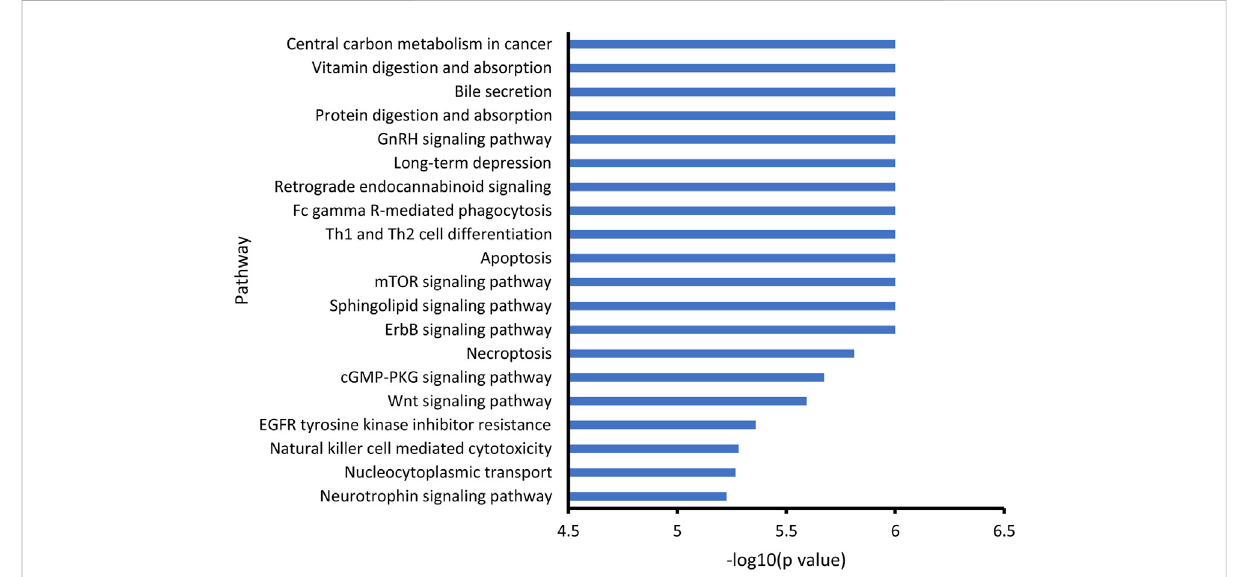
FIGURE 3 KEGG enrichment of noise-associated metabolites. R packages “ KEGGREST ” and “ FELLA ” were used for enrichment analysis. p < 0.05 was considered statistically signi fi